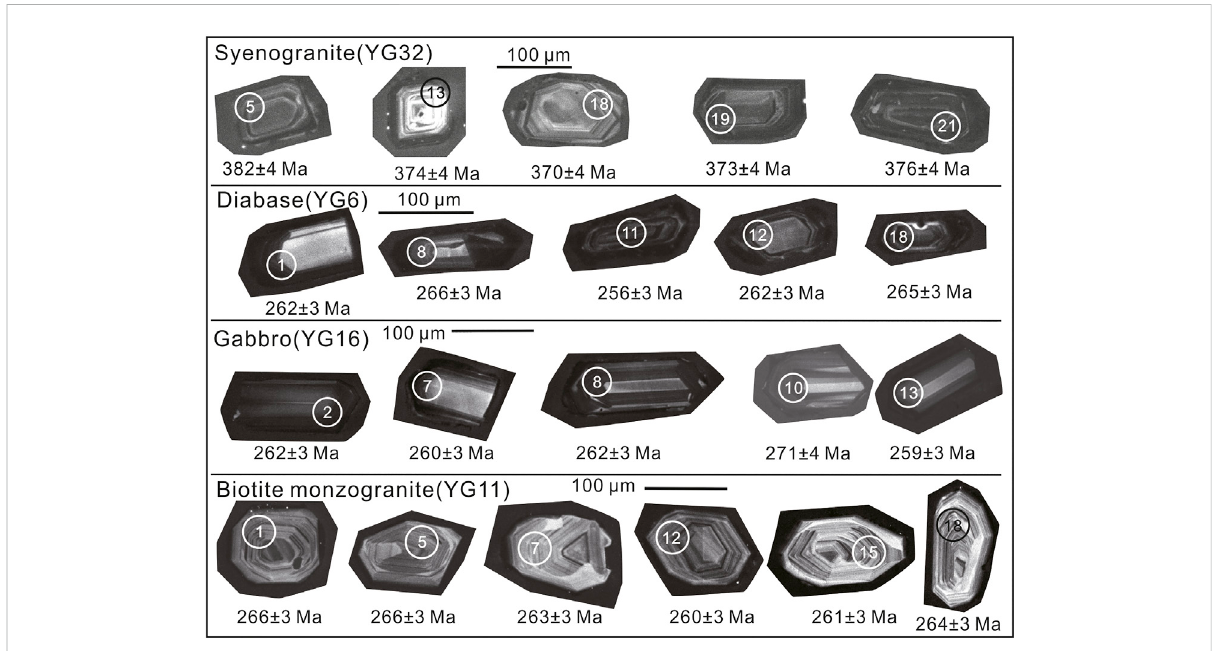
FIGURE 4 Representative zircons cathodoluminescence (CL) images for syenograntite, diabase, gabbro and biotite monzogranite in the Yagan area of northern